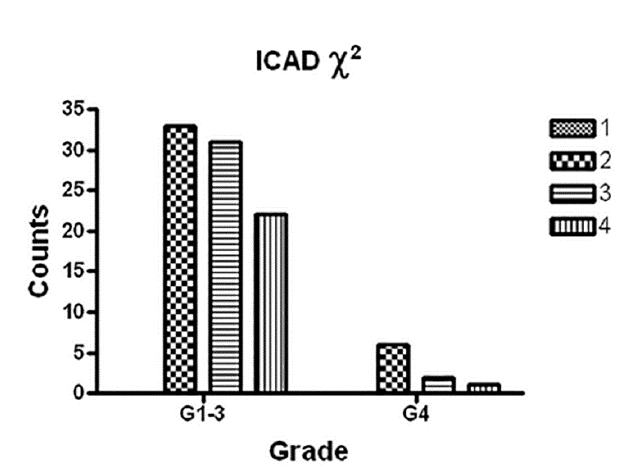
Figure 4. Graph of the  2 results for ICAD grade with protein intensity. The graphical summary of the numbers (Y axis = counts) of RCCs with a grade of 4 (G4) and those having grades 1 to 3 (G1–3) having a defined ICAD protein intensity (1 = no expression; 2–4 = low, moderate and high protein intensity). The Pearson  2 was 2.7417 with a p value of 0.254, and a Fisher’s exact p value was 0.327. Although there is clearly a decrease in ICAD intensity with high grade RCC, there was no significant